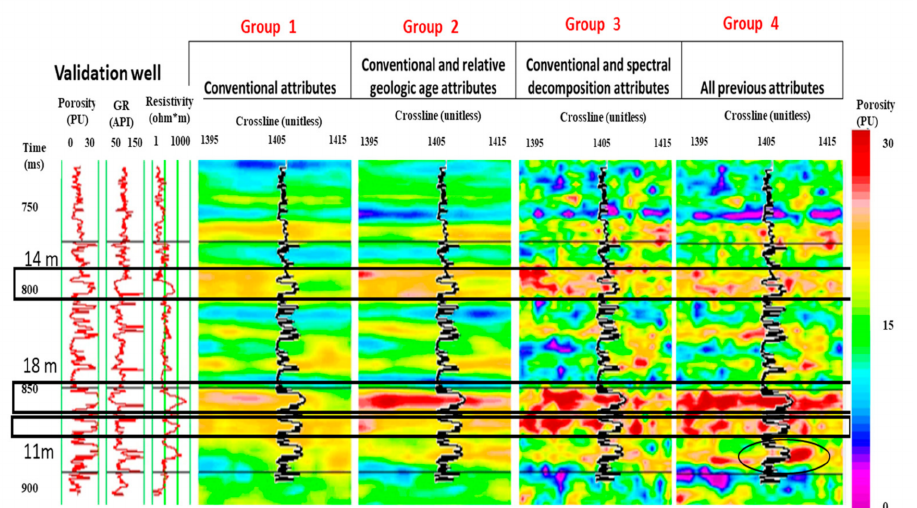
Figure 15. Thin hydrocarbon-bearing intervals seen on logs and predictions made using the four attribute groups. The inserted curve is a porosity log filtered to 100 Hz. The well shown was not used for training. Black ellipse highlights a reservoir of interest, most detectable using Group 4 prediction.